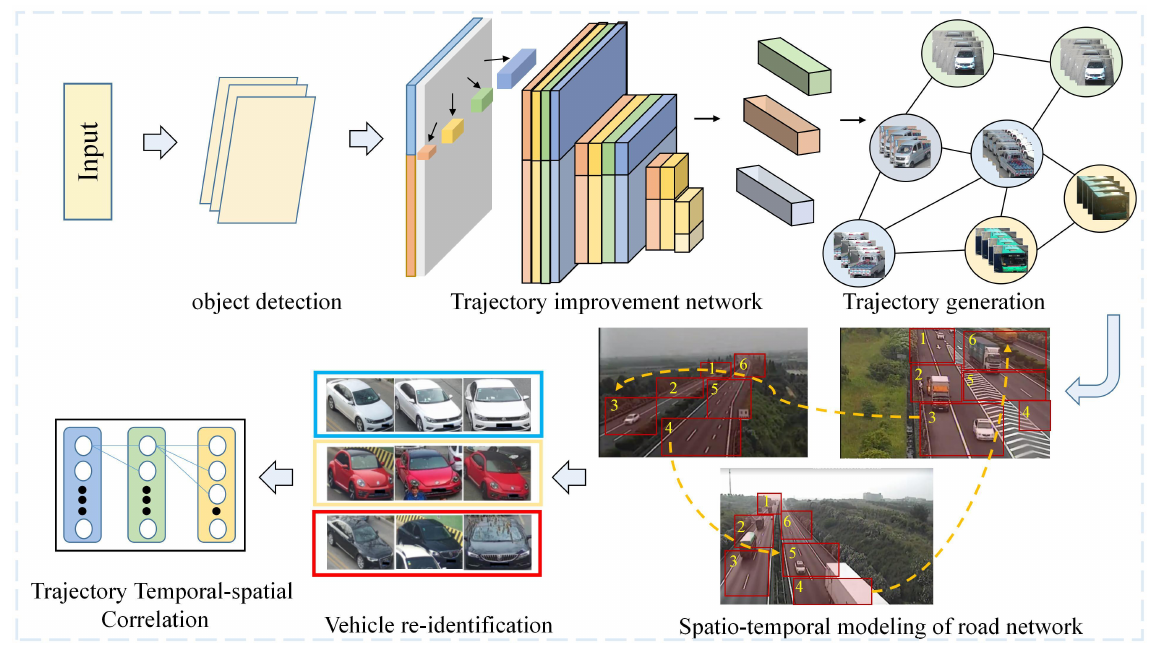
Figure 1. Cross-area tracking of vehicles with multiple objects and